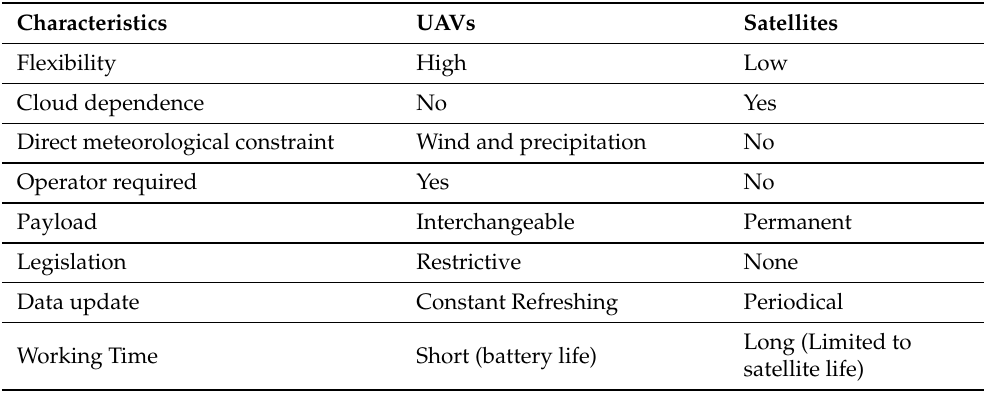
Table 1. UAV and satellite characteristics comparison.